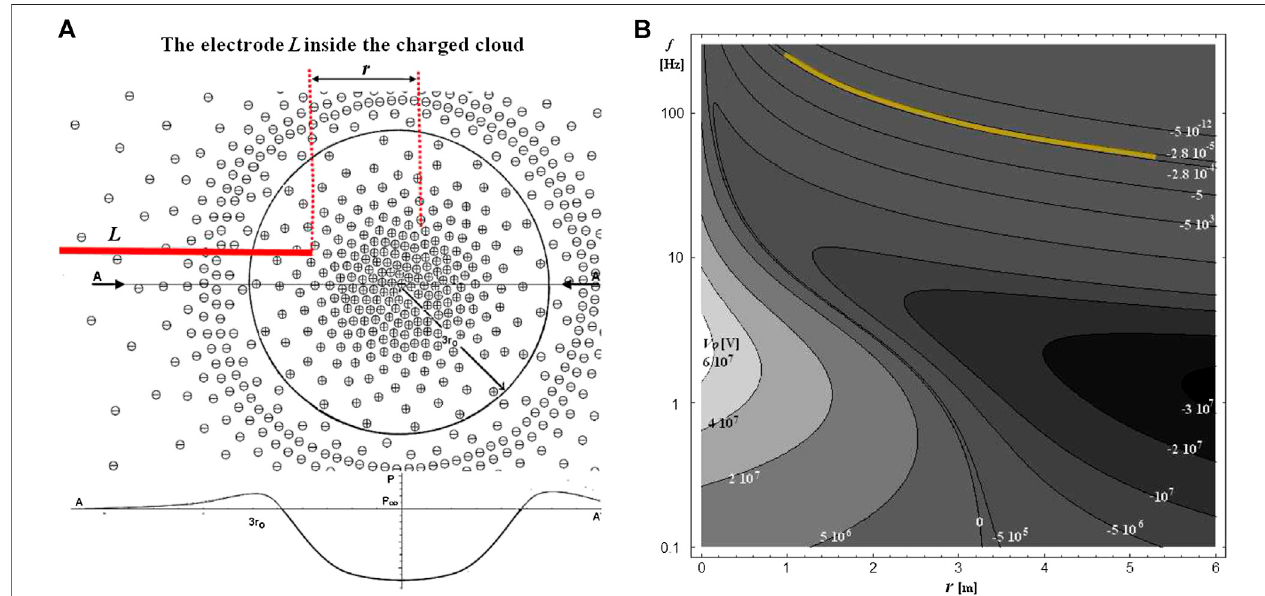
FIGURE11| Themodelofsphericalchargedcloudssurroundinganelectrodein (A) ;thecloudradiusseparatingoppositechargesis3 r o ,andthepressure P inside thesectionA-Aofthecloudisdepictedunderit,where P ∞ isthepressureof1 atmosphere.Theretrievedinducedpotential V o intheelectrode L isshownwithrespectto thedistance r andtheoscillationfrequencies f retrievedby A6 and A8 ;thesetofpossiblesolutionsforclouddistancesandfrequenciesisevidencedonthecontourplotof potentials (B) .